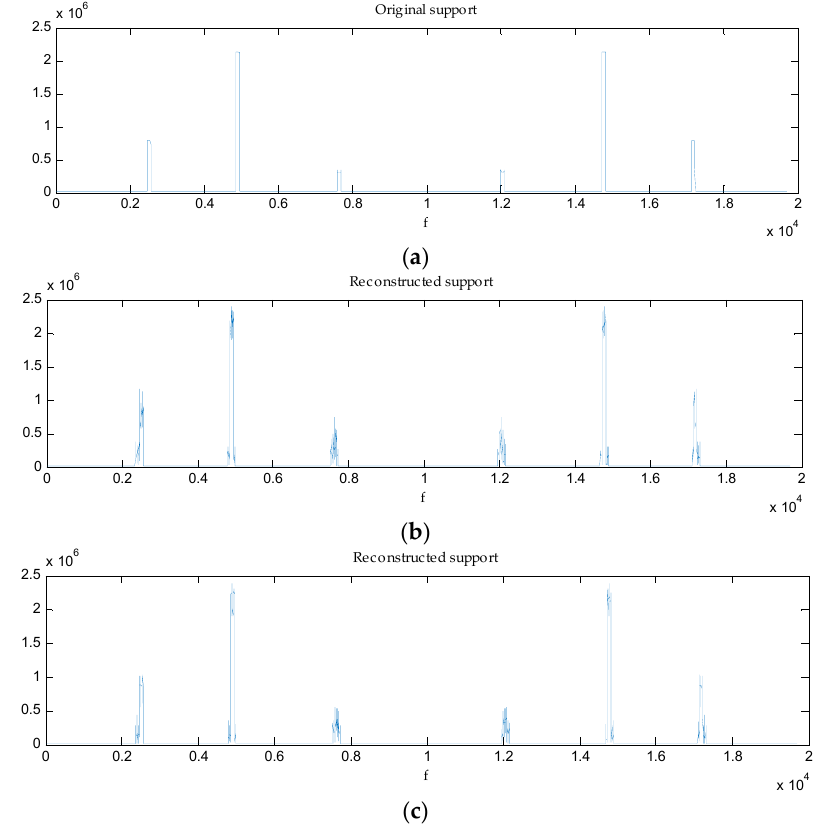
Figure 4. Frequency support recovery when N = 6. ( a ) Original support; ( b ) Reconstructed support when no θ i exists in the path; ( c ) Reconstructed support when random θ i exists in the path.